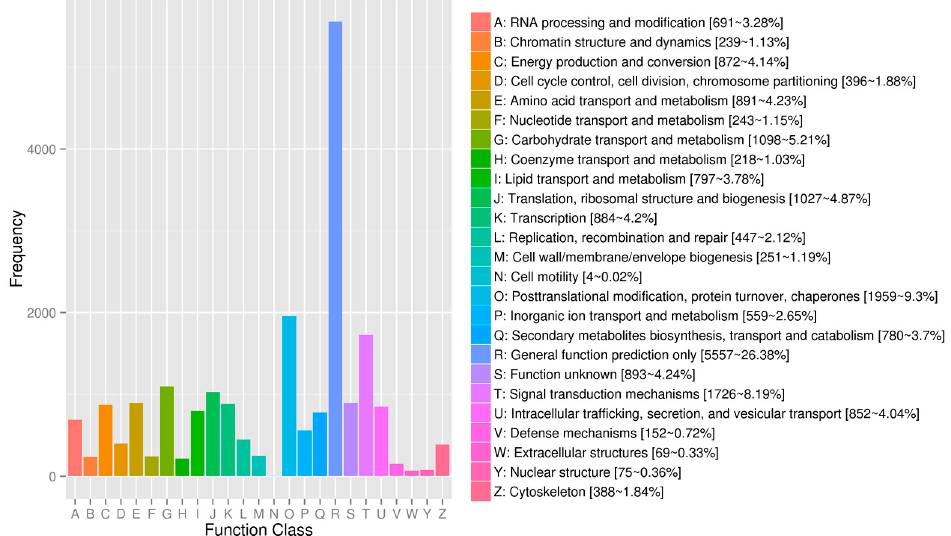
Figure 2. Eukaryotic Orthologous Groups classification of the assembled unigenes.